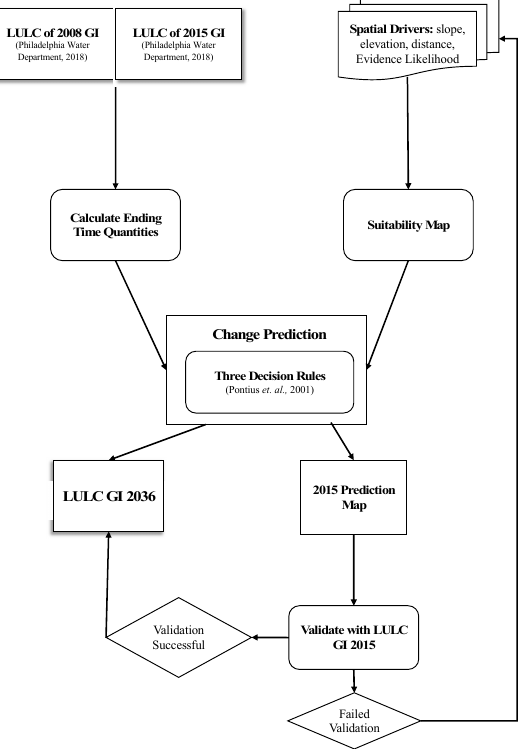
Figure 3. Process to create and validate the 2036 GI prediction using GEOMOD model based on Philadelphia’s GI plans outlined in Green City, Clean Waters [38].